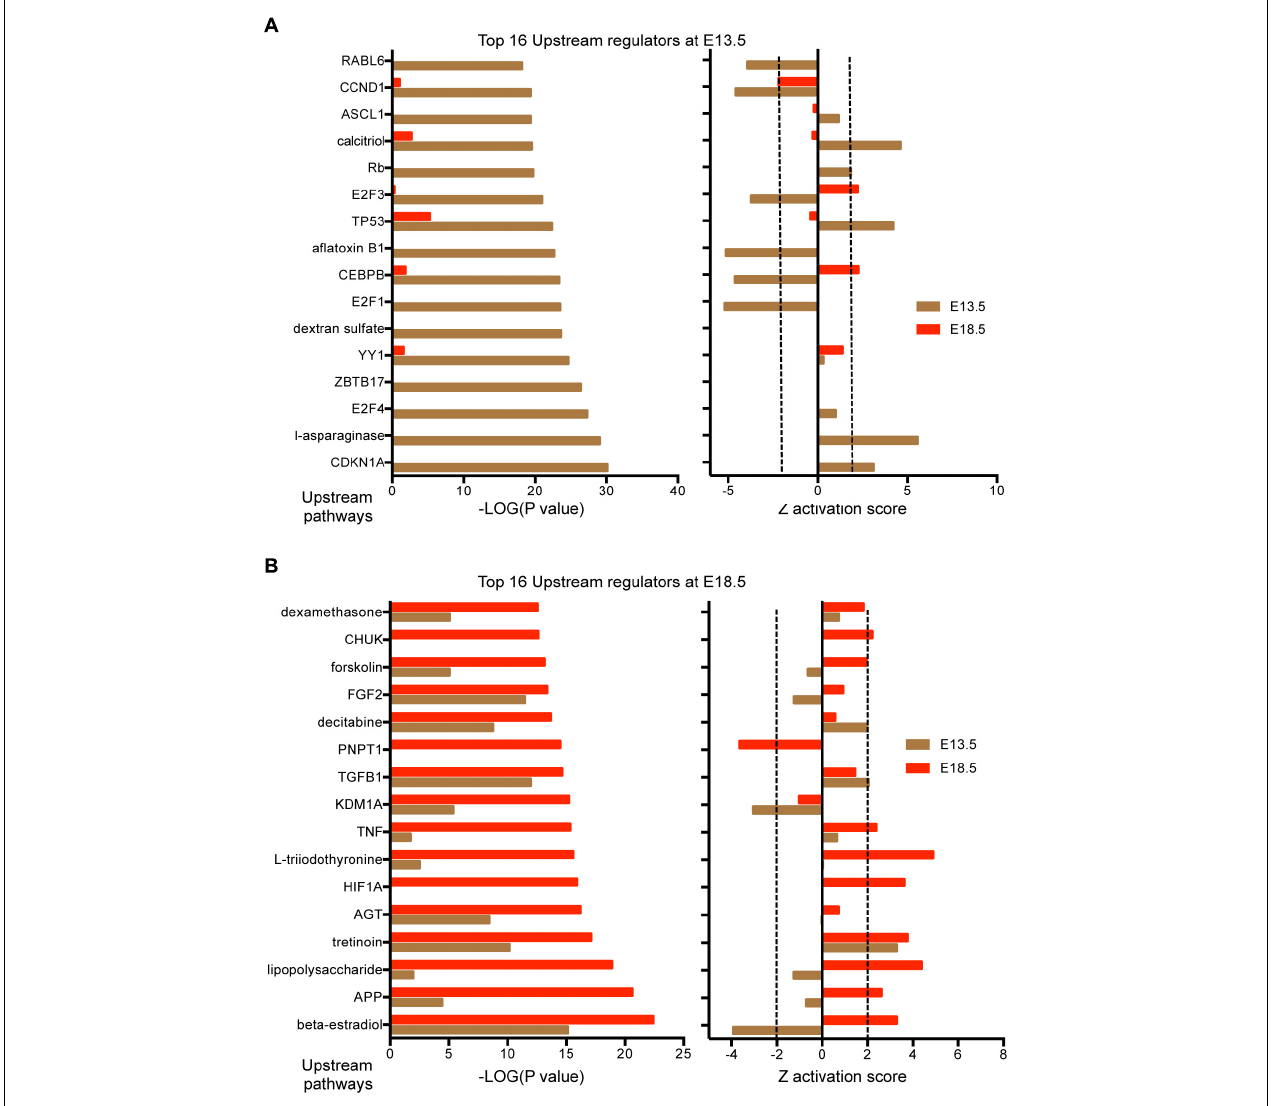
FIGURE 6 | Upstream regulators affected by DEGs in the E13.5 and E18.5 brains of Dio3 + / + and Dio3 − / − mice. (A) Top significant upstream pathways affected in Dio3 − / − mice at E13.5 with corresponding statistical values and Z activation scores at E18.5. (B) Top significant upstream pathways affected in Dio3 − / − mice at E18.5 with the corresponding statistical values and Z activation scores at E13.5. Dotted lines indicate the Z score threshold hat IPA considers significant for activation or inactivation of a certain